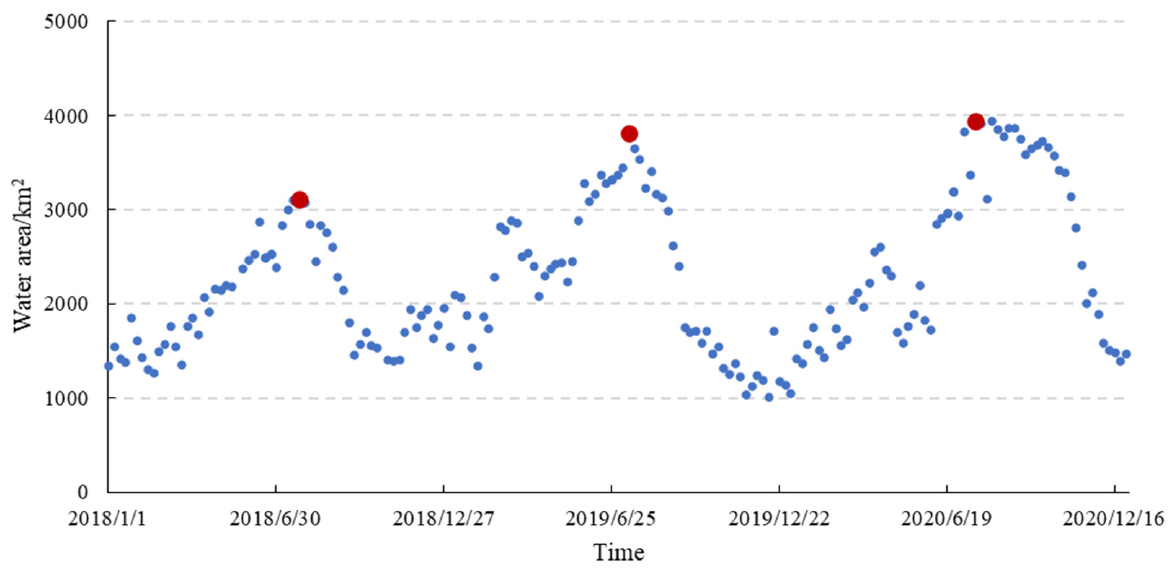
Figure 4. Time series of water surface area for Poyang Lake from 2018 to 2020. Table 2. Maximum and minimum water body and inundation areas and dates from 2018 to 2020 at Poyang